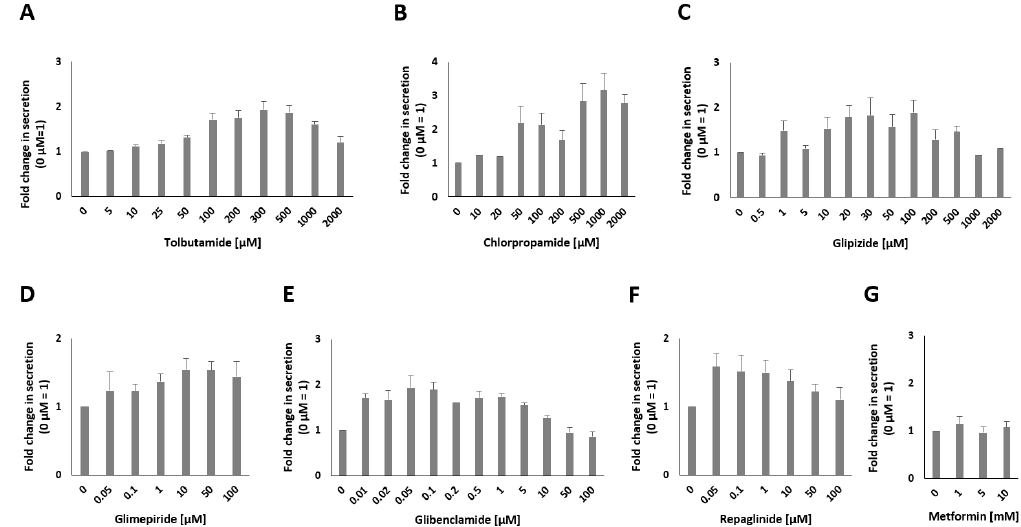
Figure A1. Fold change in the amount of insulin secreted expressed as luciferase activity in MIN6 β cells after incubation with different concentrations of tolbutamide ( A ), chlorpropamide ( B ), glipizide ( C ), glimepiride ( D ), glibenclamide ( E ), repaglinide ( F ) and metformin ( G ).